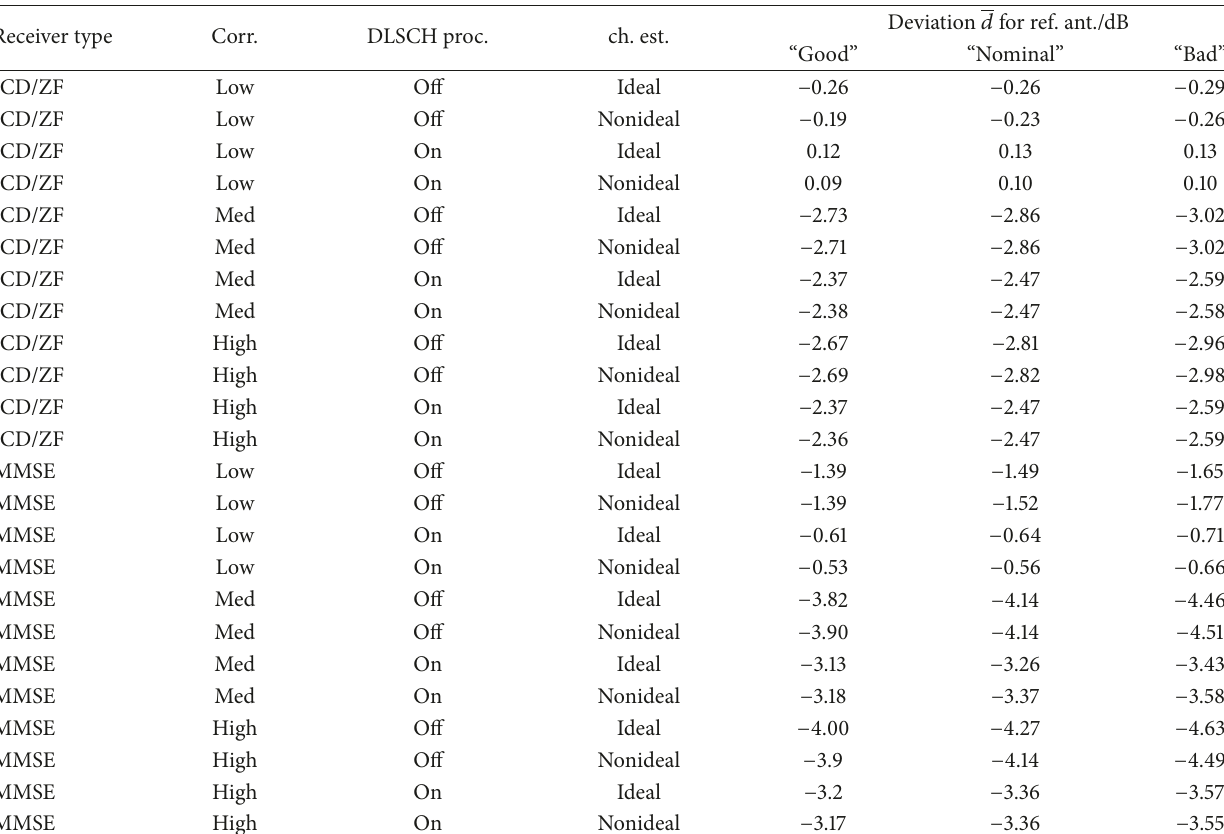
Table 2: Mean logarithmic deviations 𝑑 at 70% relative throughput using LTE reference antennas “Good”; “Nominal”; and “Bad” with parameters: channel correlation type, DLSCH processing, and channel